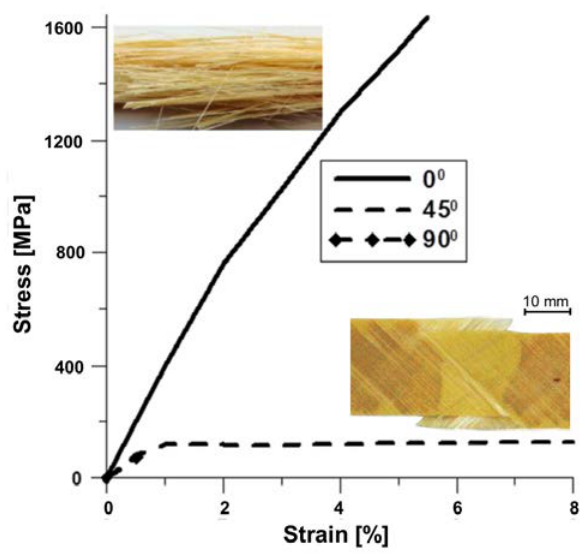
Figure 3. The stress–strain diagrams and photographs of failure modes for unidirectional specimens under tensile loading.